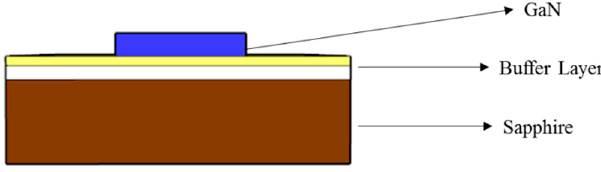
Figure 2. Illustration of the GaN / sapphire semiconductor’s structural layers. Table 1. Design specification for the proposed splitter.